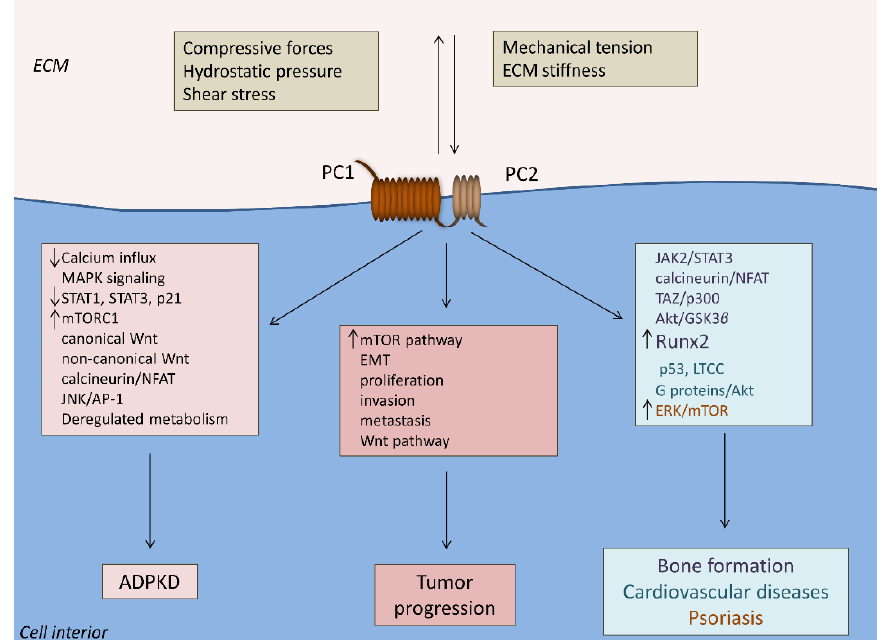
Figure 2. Polycystin-associated pathogenic mechanisms in human diseases. PC1 and PC2 form complexes at the cell surface and sense alterations of extracellular cell-specific mechanical forces. PC1 and PC2 loss of function induces distorted mechanotransduction that promotes ADPKD. PC1 and PC2 tissue-specific function in cancer cells facilitates tumor progression. PC1 and PC2 induce Runx2 upregulation and promote osteoblastogenesis under mechanical tension, whereas PC1 downregulation activates the mTOR pathway and mediates the properties of psoriasis in keratinocytes such as increased cell proliferation, migration, inflammation, and angiogenesis. PC1 and PC2 have also been implicated in atherosclerosis and cardiomyopathy molecular mechanisms.